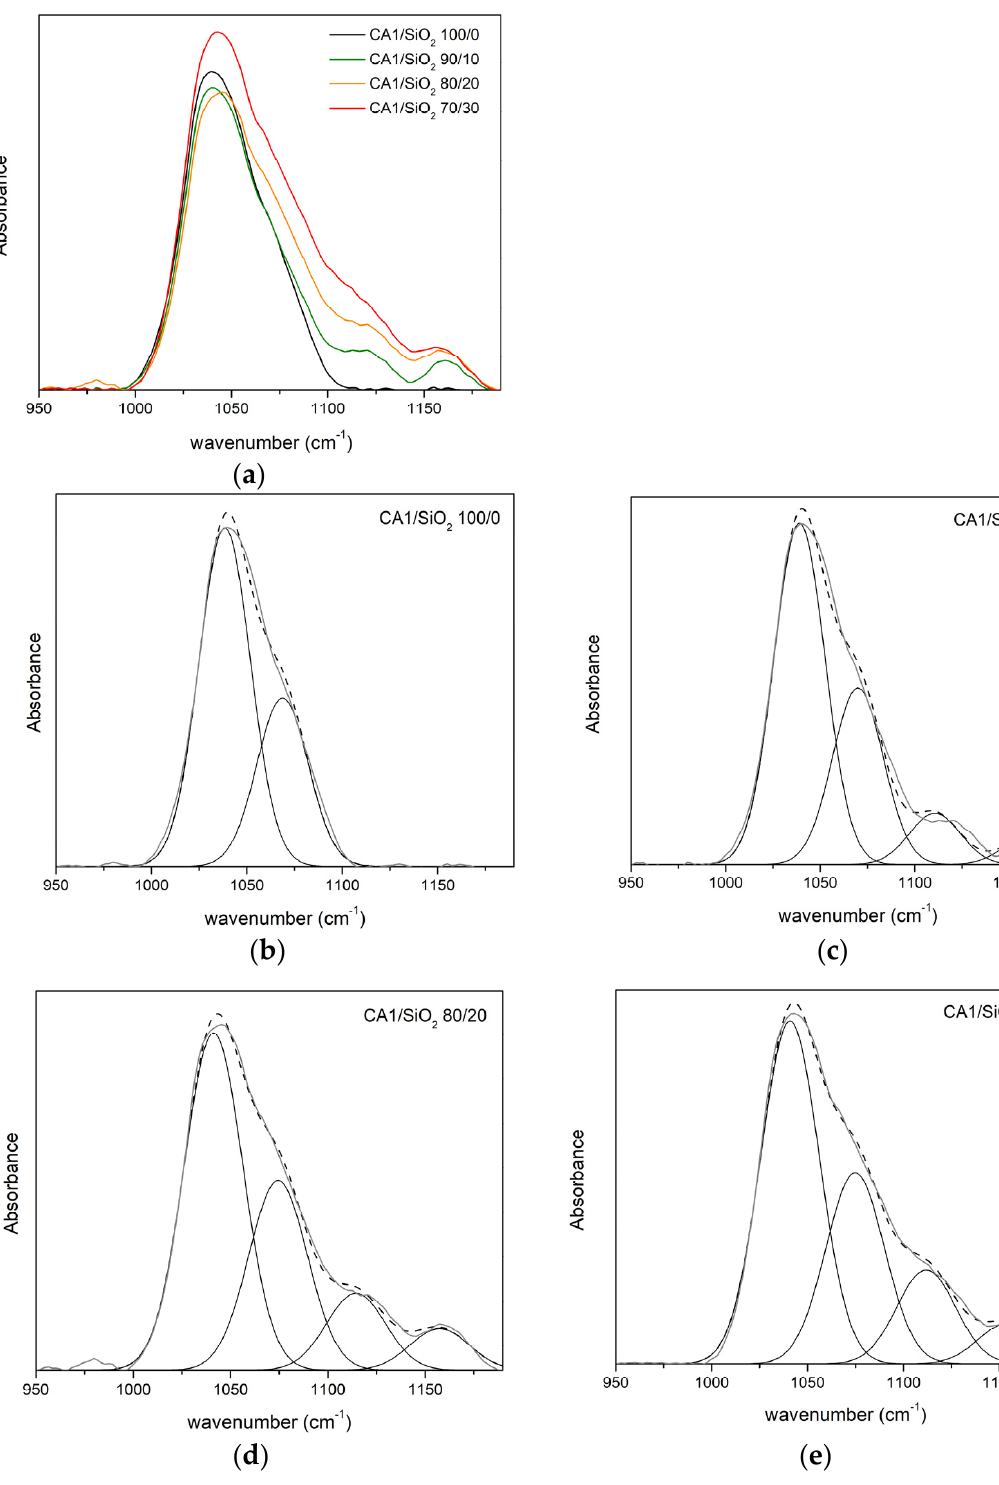
Figure 7. FTIR-ATR absorption spectra of the membranes from series one: CA1/SiO 2 100/0, 90/10, 80/20, and 70/30 membranes: ( a ) in the region 950–1190 cm − 1 and ( b – e ) curve-fitting decomposition of the bands ν (C-O), ν δ (Si-O-Si), and ν δ (Si-O-C), present in the spectra obtained for: ( b ) CA1/SiO 2 100/0 membrane, ( c ) CA1/SiO 2 90/10 membrane, ( d ) CA1/SiO 2 80/20 membrane, and ( e ) CA1/SiO 2 70/30 membrane. Experimental results are shown by the thick grey line and the simulated band by the black dashed line. Table 2. Series one: frequency ( ν ) and relative area (A %) of the bands ν δ (C-O), ν δ (Si-O-Si), and ν δ (Si- O-C).